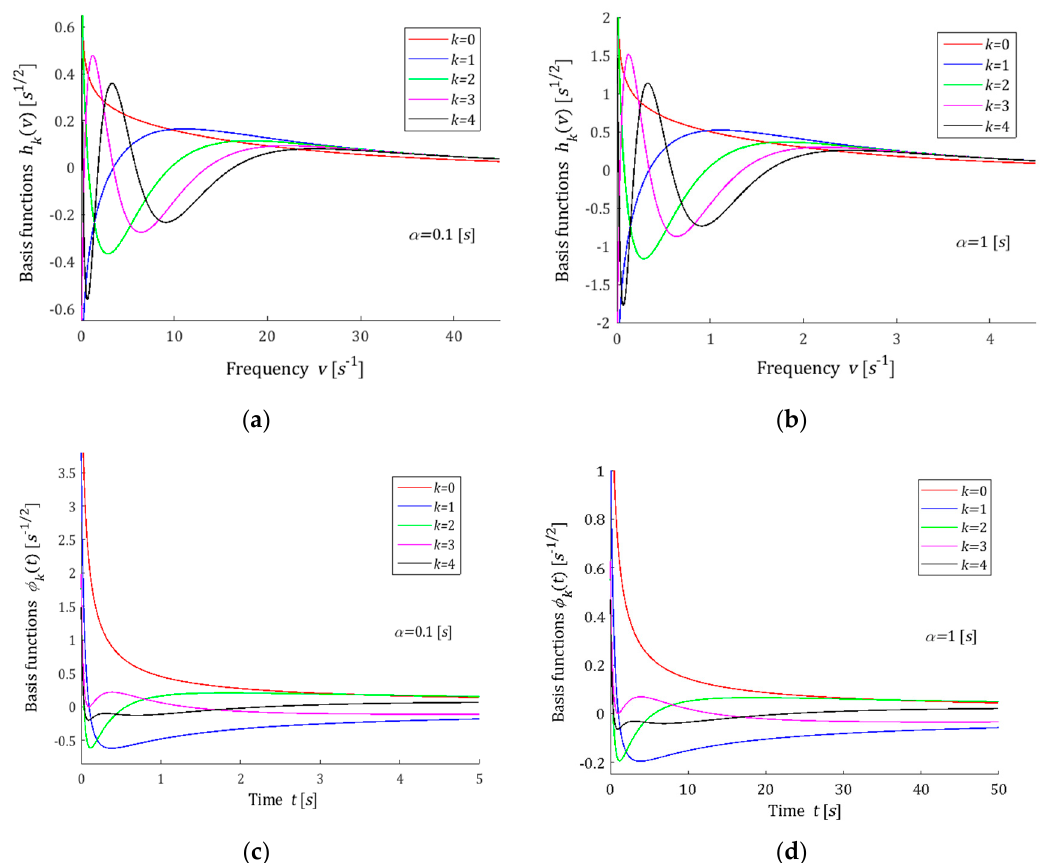
Figure 3. Basis functions h k ( v ) (38), (39) and φ k ( t ) (40)–(43) of the Chebyshev model for two time- scaling factors: ( a ) h k ( v ) , α = 0.1 [ s ] ; ( b ) h k ( v ) , α = 1 [ s ] ; ( c ) φ k ( t ) , α = 0.1 [ s ] ; ( d ) φ k ( t ) , α = 1 [ s ] ; 𝑘 = 0,1,2,3,4 .